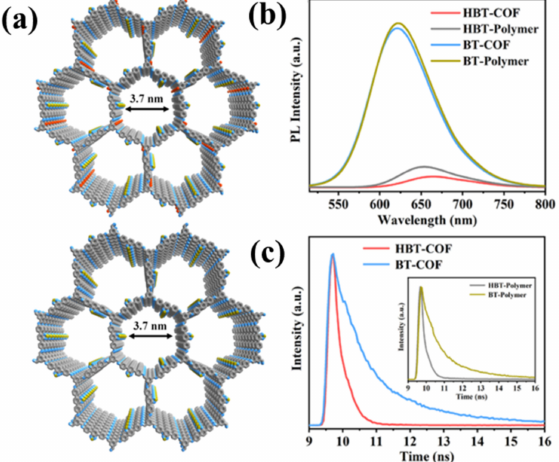
Figure 8. ( a ) Top views of the ideal eclipsed structures of HBT-COF ( top ) and BT-COF ( bottom ). ( b ) PL spectra ( λ ex = 450 nm). ( c ) TRPS ( λ ex = 475 nm, λ em = 665 nm). Reproduced with